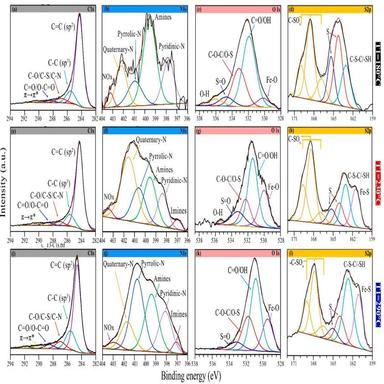
Cristina L. Rodríguez-Corvera et al. Deconvoluted high-resolution XPS spectra for C1s, N1s, O1s, and S2p. The fitting was performed using Gaussian-Lorentzian curves (GL(30)). The results of T1 = 180, 230, and 290 ◦C are in the first, second, and third columns, respectively.